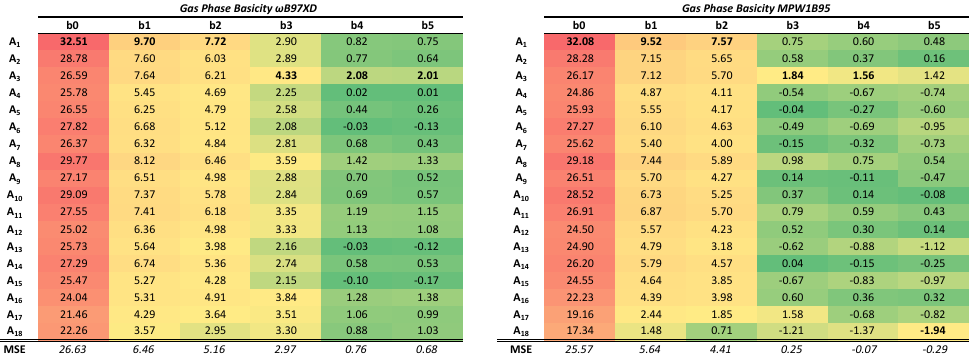
Table 2. Signed relative errors at each theoretical level and mean signed errors (MSE) for each basis set in the values obtained for the gas-phase basicities (GPBs). The color scale used, method of cell coloring, and basis set employed are the same described for